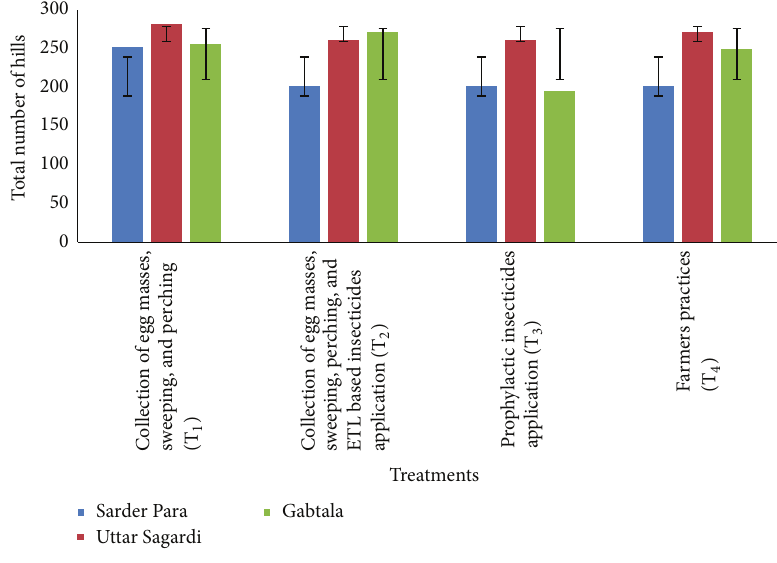
Figure 5: Total number of hills per 10m 2 .